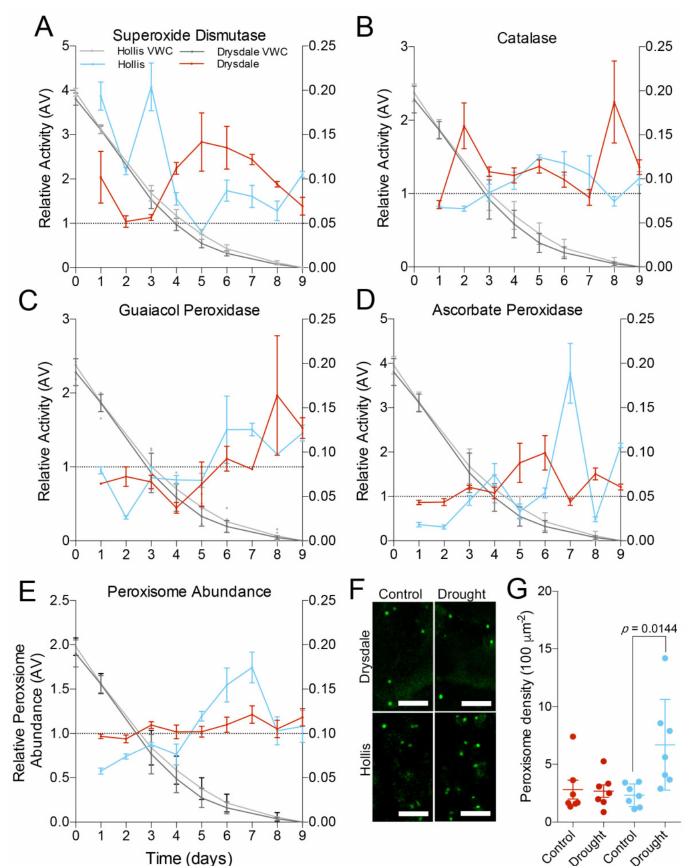
Figure 4. Relative activity of ROS scavenging enzymes during drought stress. The charts show the fold change of the enzyme activity in the drought-stressed samples relative to the control. The right Y-axis shows volumetric water content (VWC) at the corresponding time points. ( A ) Superoxide dismutase. ( B ) Catalase. ( C ) Guaiacol peroxidase. ( D ) Ascorbate peroxidase. ( E ) Peroxisome abundance. The values in A–E represent the mean ± SD of 5 biological replicates for both control and drought. Values above the dashed line indicate up-regulation; values below the line indicate down-regulation. ( F ) Representative images of peroxisomes in leaf epidermis cells of watered and drought-stressed Drysdale and Hollis plants. Scale bar, 5 mm. ( G ) Average density of peroxisomes per 100 mm 2 of leaf surface in leaf epidermis cells of watered and drought-stressed Drysdale and Hollis plants. Seven cells were measured per each genotype and